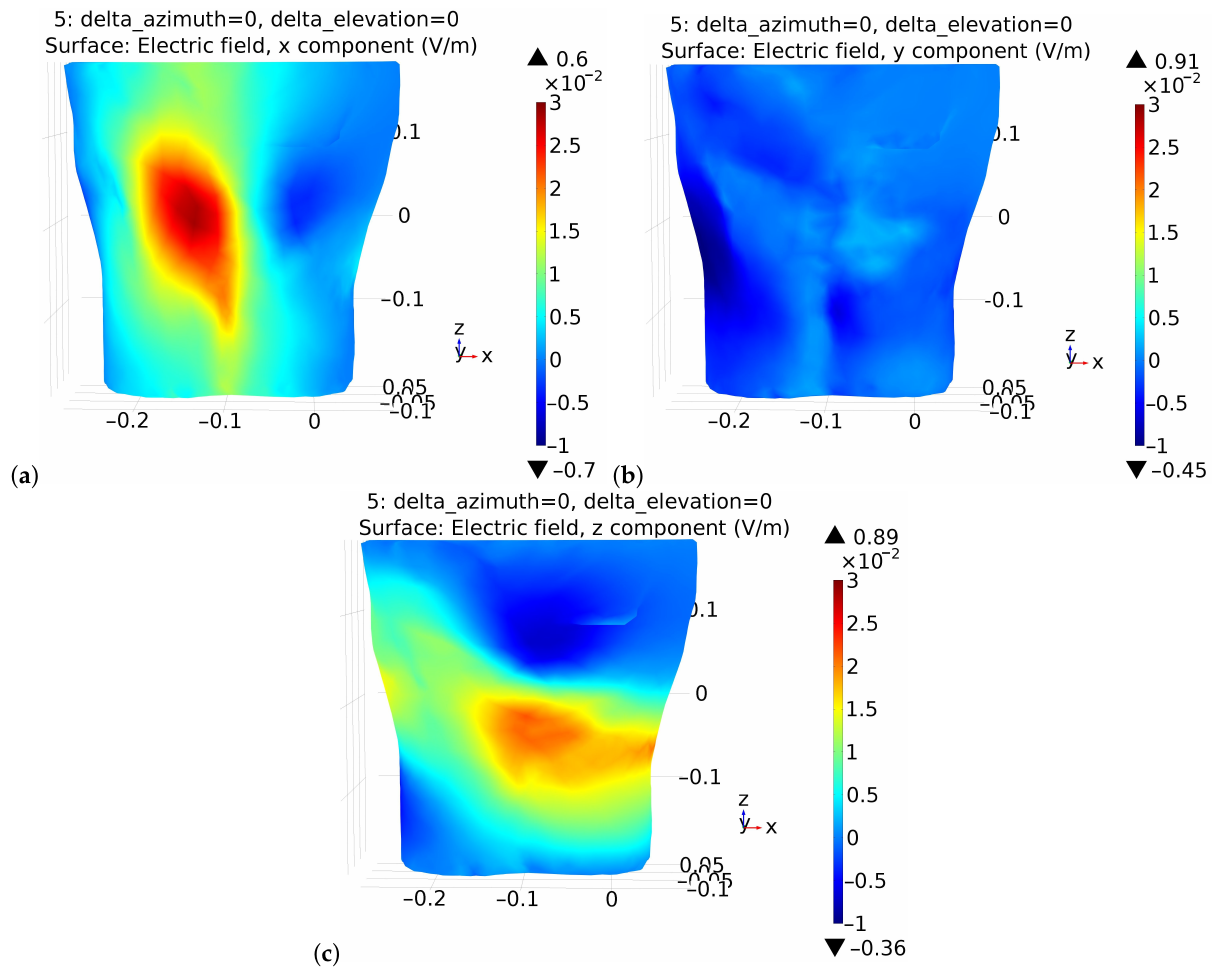
Figure 4. Electric field distribution on the back ( a ) Ex, ( b ) Ey, and ( c ) Ez components, respectively.